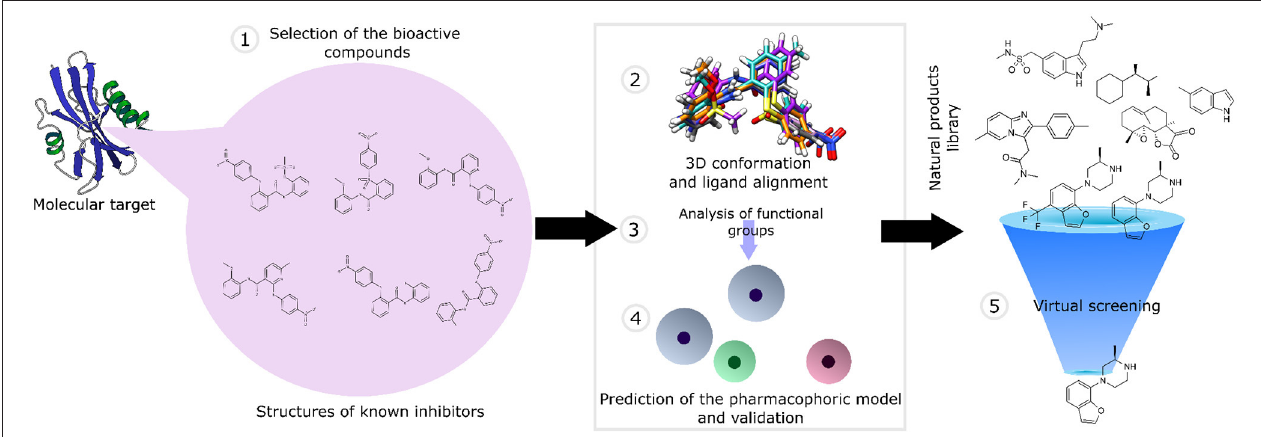
FIGURE 3 | An overview of pharmacophore-based virtual screening applied for natural product libraries.